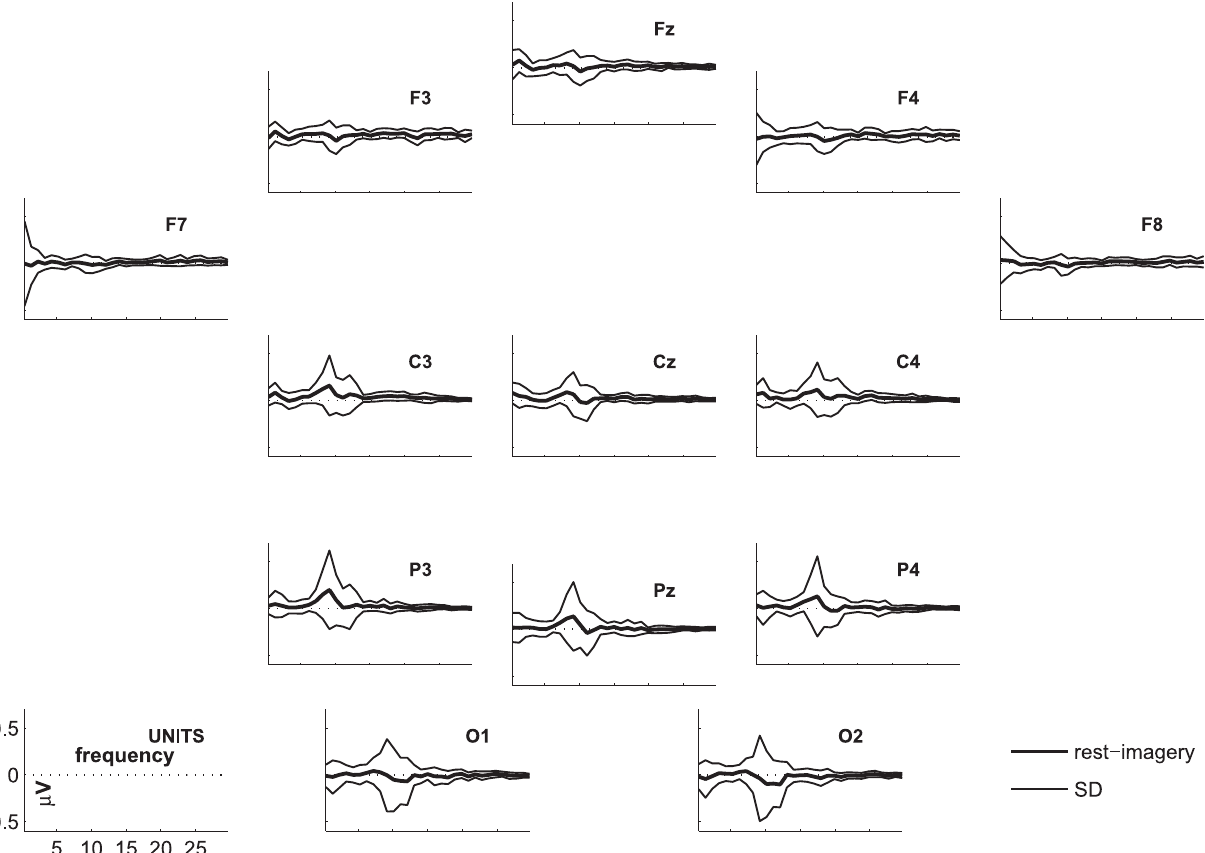
Figure 2. Differences in power spectra (rest-imagery) in healthy participants. Thick line indicates the mean of the sample, the thin lines indicate the standard deviation.